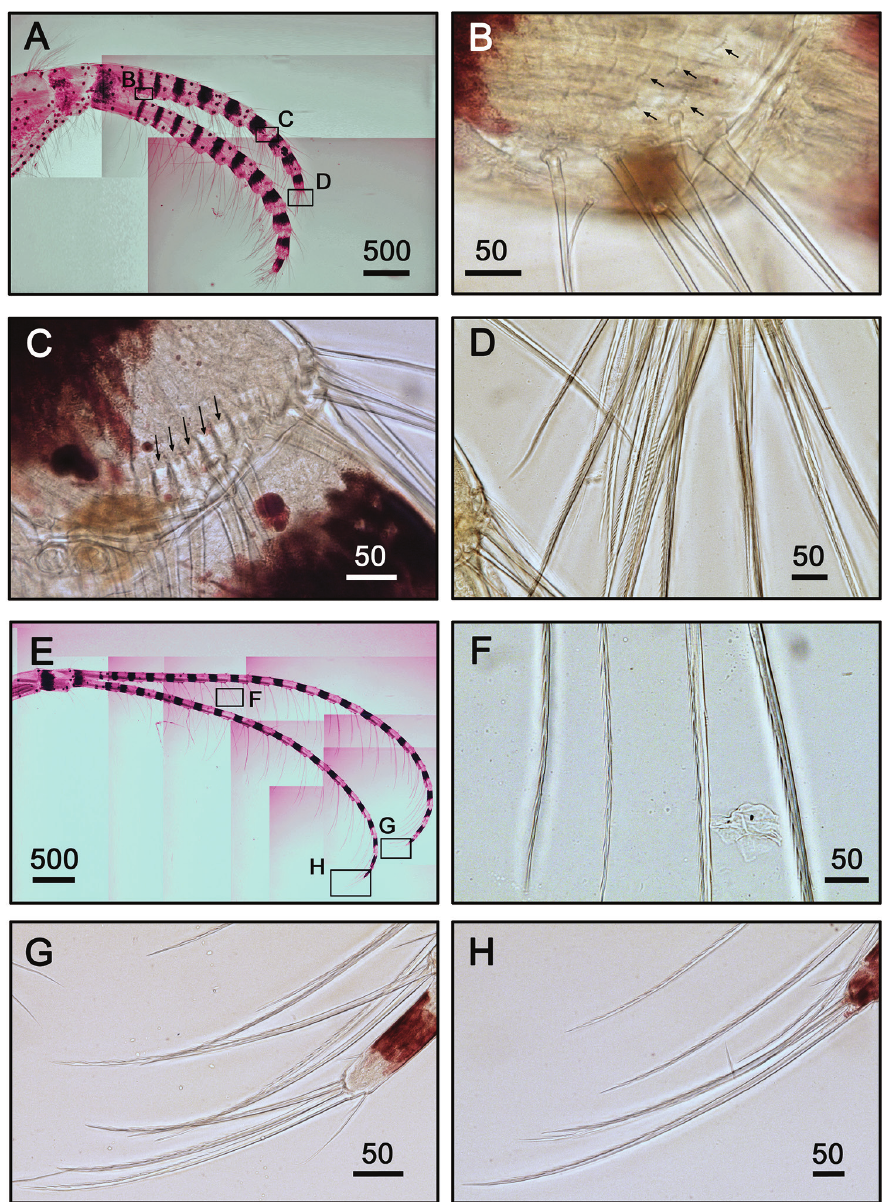
Figure 8. Cirrus III, IV of Galkinius maculosus sp. n. A Cirrus III with dark spots and stripes on each segment, rami almost equal length (ASIZCR000343) B Fan-shaped denticles on the surface of basal seg- ments of posterior ramus (indicated by arrows) C Series of conical spines at the margin of distal segments of posterior ramus (indicated by arrows) D Simple and serrulate setae on the distal segment of posterior ramus E Cirrus IV, with stripes on each segment, rami almost equal length (ASIZCR000343) F simple and serrulate setae on intermediate segment G Simple and serrulate setae on the distal segment of poste- rior ramus H Simple and serrulate setae on the distal segment of anterior ramus. Scale bars in